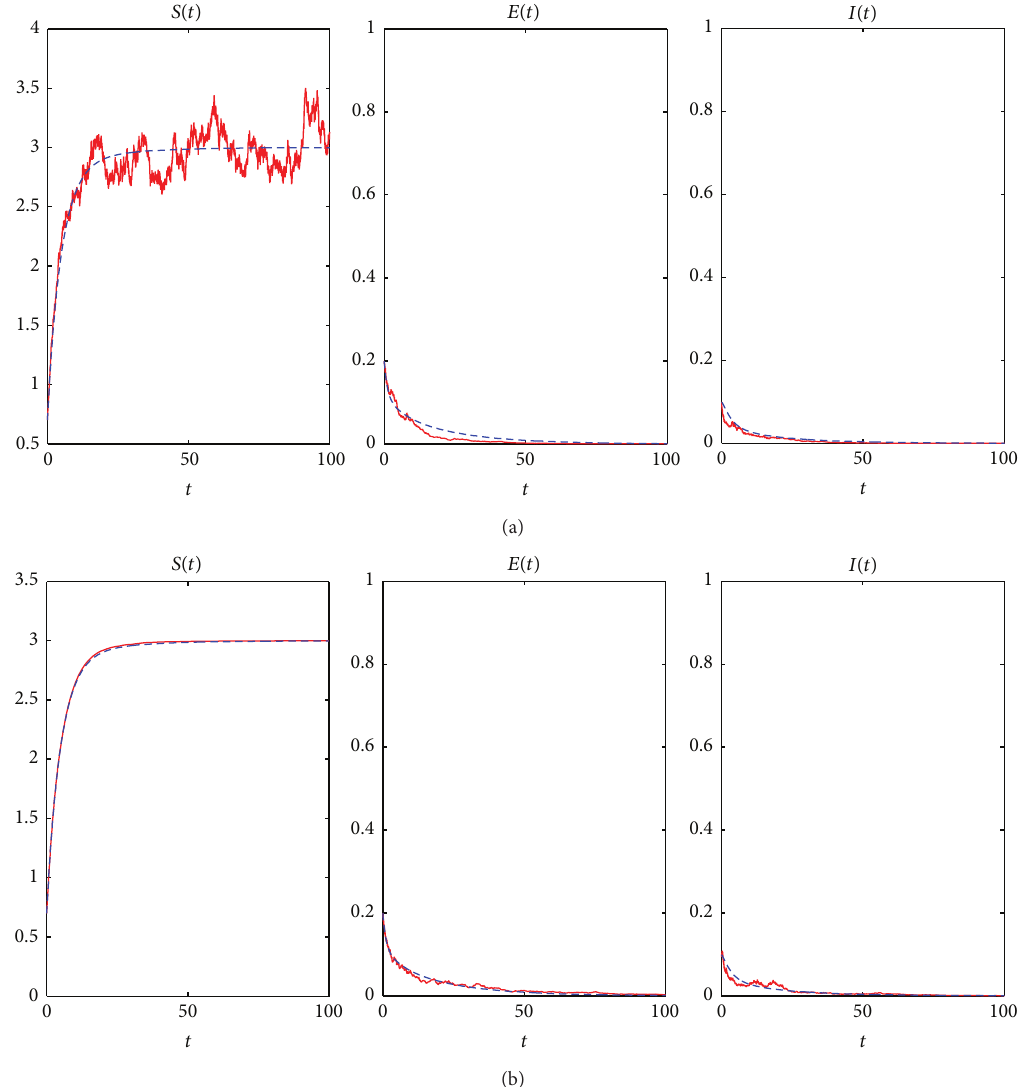
Figure 2: 𝑆(0) = 0.7 , 𝐸(0) = 0.2 , 𝐼(0) = 0.1 , Λ = 0.6 , 𝛽 = 0.4 , 𝜇 = 0.2 , 𝛿 = 0.1 , 𝛾 = 0.2 , 𝜖 = 0.15 , 𝑑 = 0.1 , and Δ𝑡 = 0.002 . Group (a) 𝜎 1 = 0.04 , = 0.1 , and 𝜎 = 0.2 . Group (b) 𝜎 𝜎 2 3